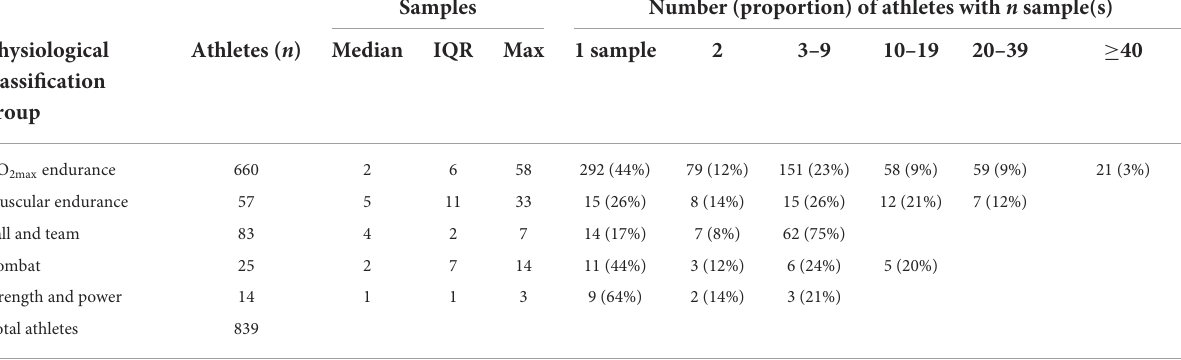
TABLE 4 Number of hematological ABP samples per athlete collected in 2010–2019 by physiological classification. Samples